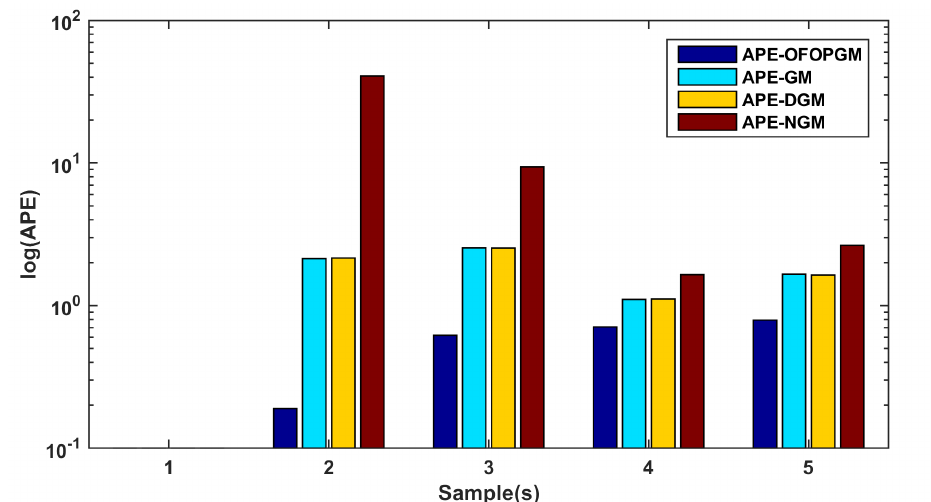
Figure 2. APE—energy consumption forecast.